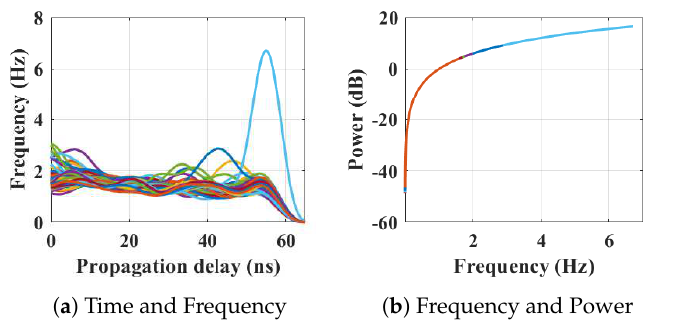
Figure 12. The relationship between propagation delay, activity frequency, and received power from the radar responses obtained while the person is returning from the bathroom to the living room has been considered as C9 in classification